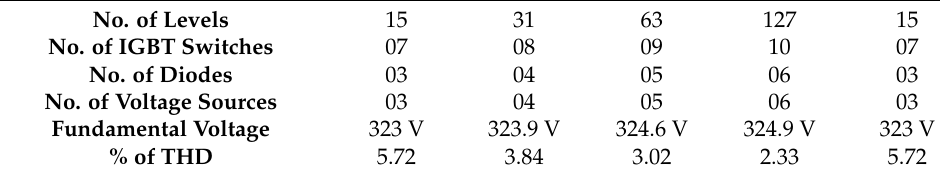
Table 2. Comparison of various reduced switch MLIs.